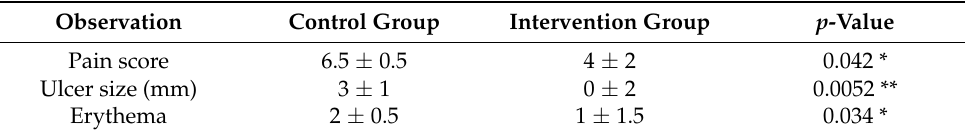
Table 4. Clinical assessment of human volunteers on the fourth day.